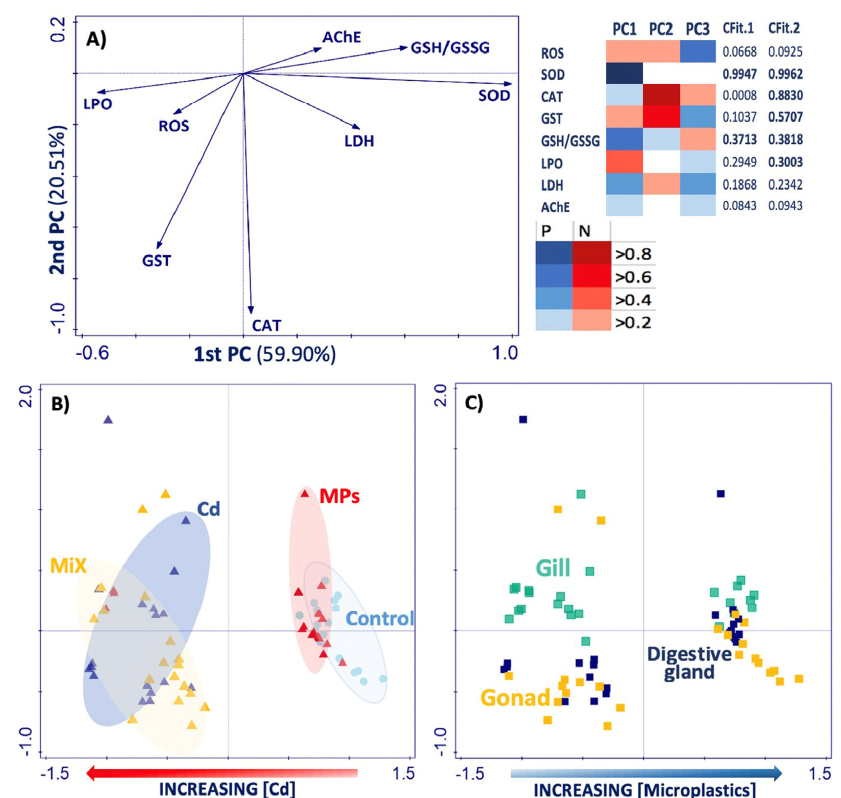
Figure 3. ( A ) Principal component analysis (PCA) based on ( B ) biochemical variables analyzed in Corbicula fluminea exposed to MPs and Cd, alone or combined (MIX), in different organs, ( C ) Gill, Gonad and Digestive gland. Correlation of the individual response variables to the different ordination axis, blue indicate positive, and red negative, relationship with principal components, deeper color means higher correlation. Additionally, the cumulative fraction of variation in individual response variables by the first two axes is shown.